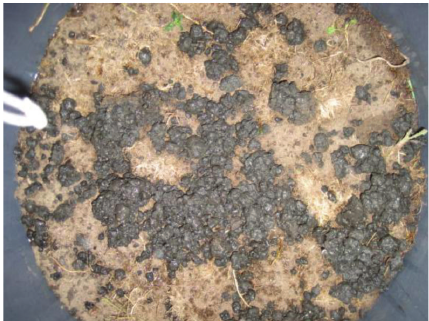
Table 2: Number of samples collected at each site and